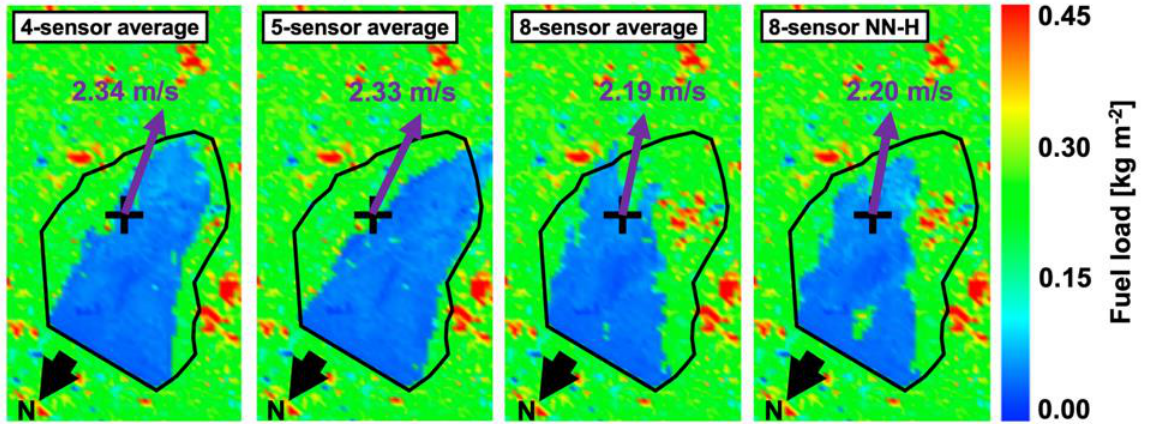
Figure 7. FIRETEC simulations, initialized with averaged wind data, of fuel consumption within the S5 burn plot 320 s after ignition. Four-sensor average winds are generated by averaging data from anemometers A31, A60, A73, and A80. Five-sensor average winds are generated using anemometers A26, A31, A60, A80, and A81. Eight-sensor average and eight-sensor nearest neighbor winds are generated using anemometers A26, A31, A41, A42, A60, A73, A80, and A81. Fuel consumption is shown on the S5 burn plot domain, not the entire computational grid.